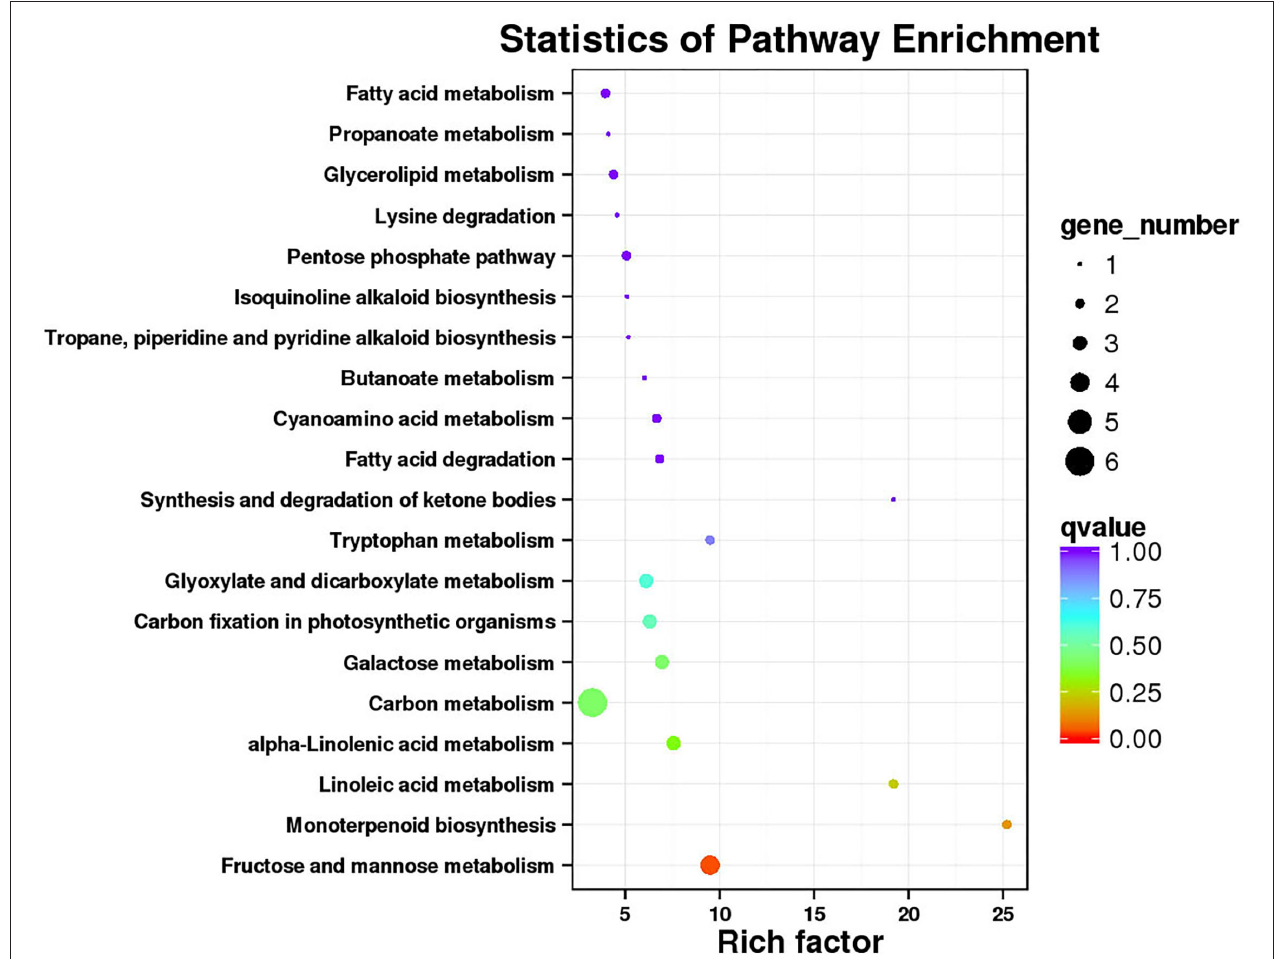
FIGURE 8 | Functional annotation and Kyoto Encyclopedia of Genes and Genomes (KEGG) pathway enrichment of hub genes in